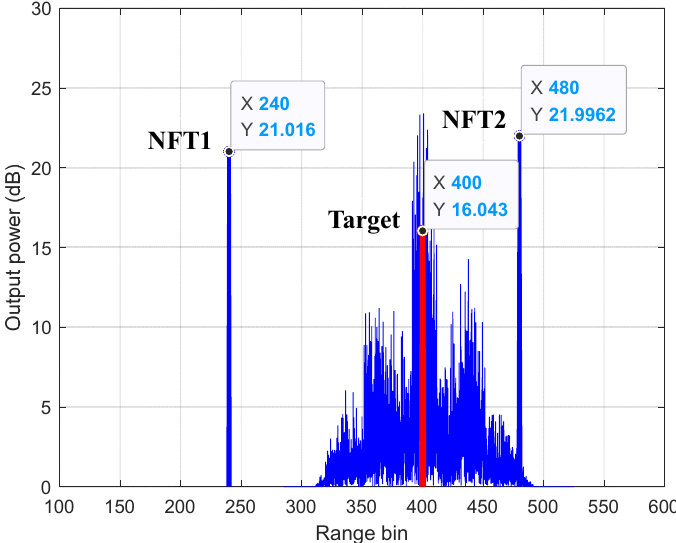
Figure 10. Analysis results of new jamming range bin under range-angle two-dimensional MVDR adaptive beamforming.